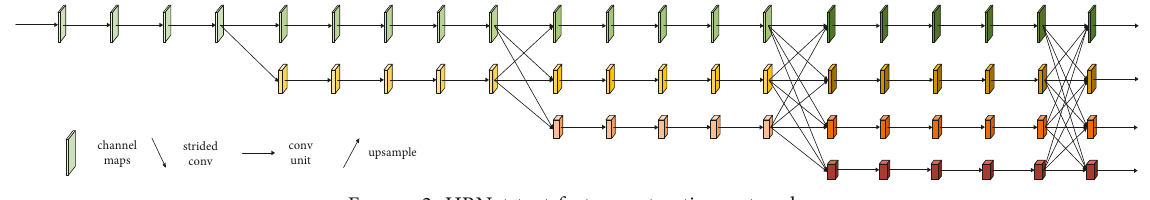
Figure 2: HRNet text feature extraction